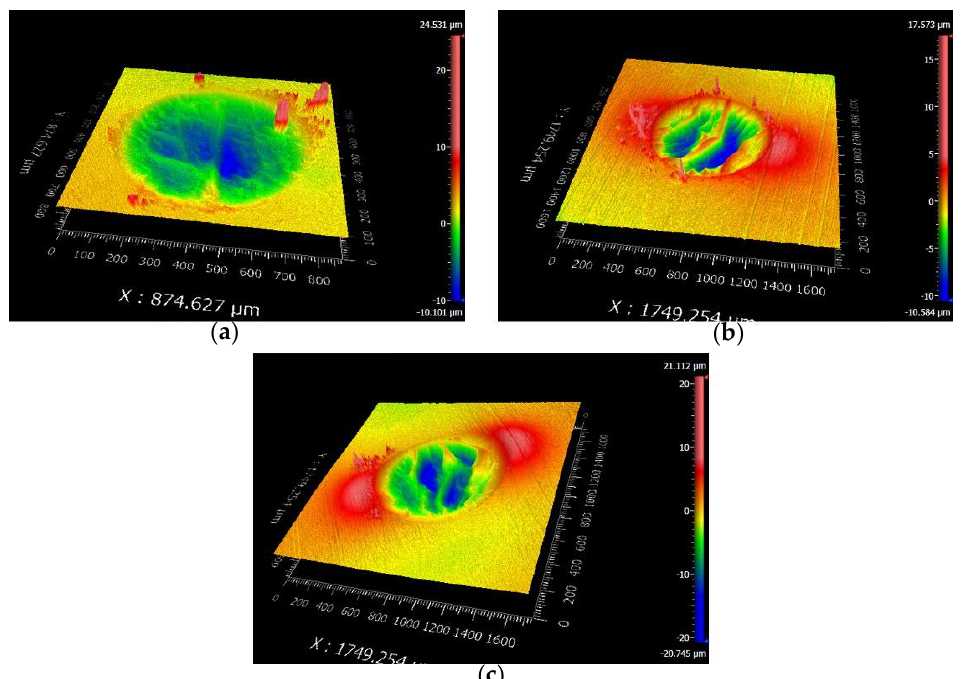
Figure 14. The 3D shape of PVDF thin films with ƒ = 15 Hz, D = ±20 μm, and V c = 0 V: (a) F n = 15 N,